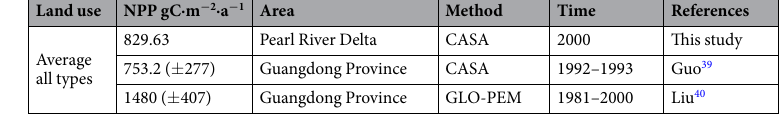
Table 4. NPP values obtained in this study, compared with values from the